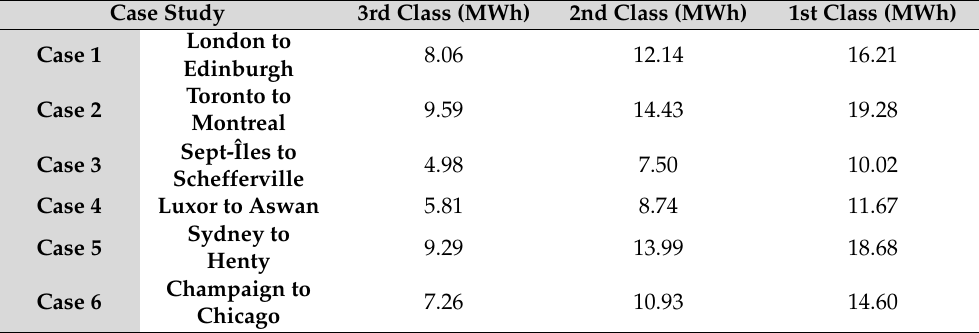
Table 4. The annual energy consumed per each class of wagons for the case